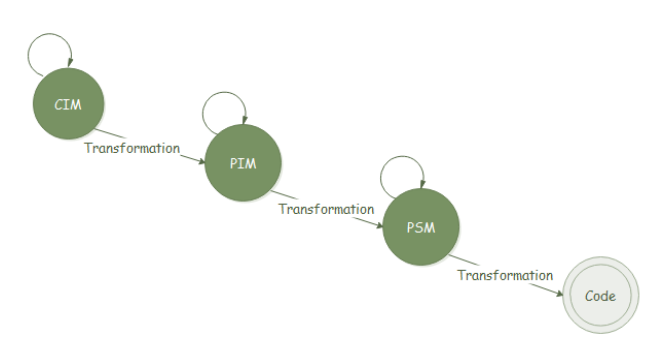
Fig. 1. Model Driven Architecture